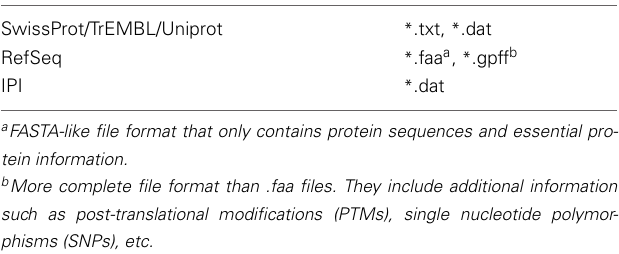
can be done with (B) or without (C) the presence of a background proteome. It is noteworthy that the presence of a background proteome (as in the case of xenografts) (B) will generally reduce the number of surrogate peptide candidates compared to the list of peptides obtained in (C) .